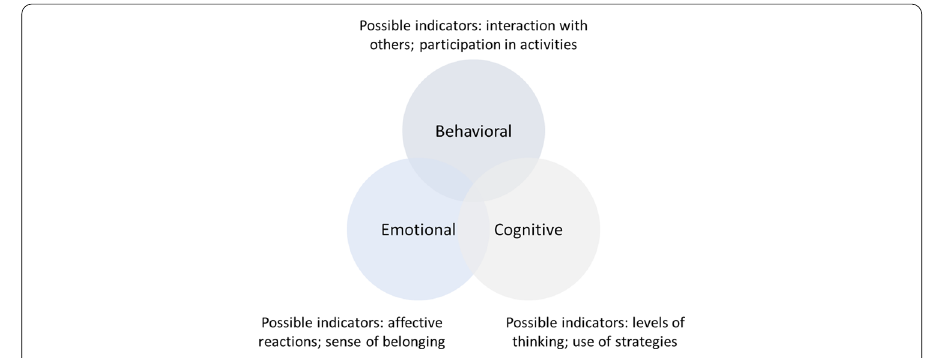
Fig. 2 Three dimensions of engagement and examples of indicators for each